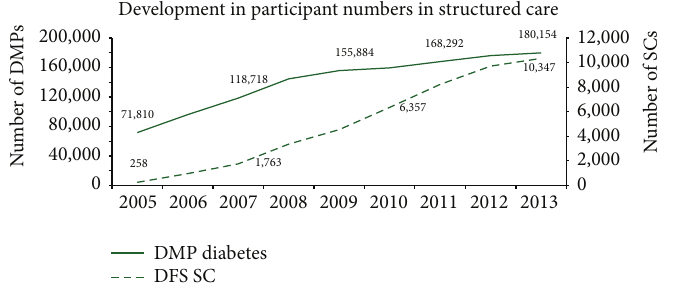
Figure 2: Development in participant numbers in the DMP and DFS selective contract (SC).